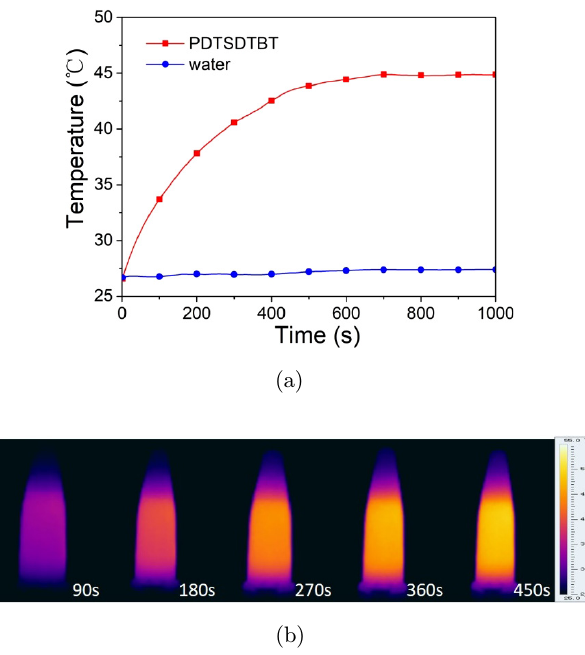
Fig. 7. Photothermal properties of nanoparticles solution ( ½ nanoparticles (cid:7) ¼ 100 (cid:2) g mL (cid:4) 1 , 1 W cm (cid:4) 2 Þ . (a) Temperatures of PDTSDTBT nanoparticles solutions as a function of laser irradiating time. The photothermal imaging of PDTSDTBT nanoparticles solution under 660 nm laser irradi- ation for 90, 180, 270, 360 and 450 s,